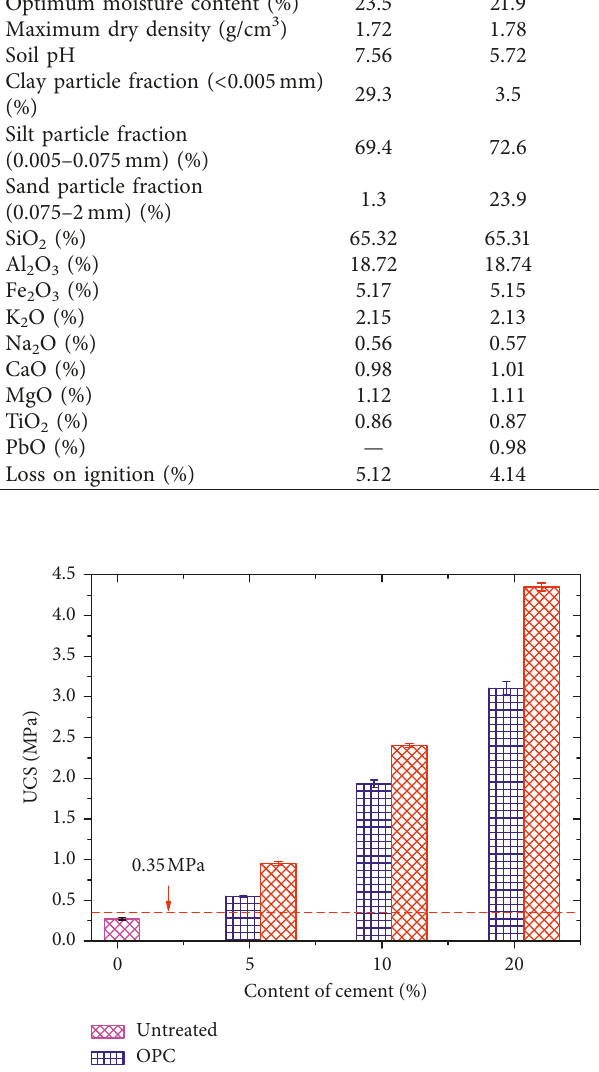
Figure 1: Unconfined compressive strength of the solidified/sta- bilized